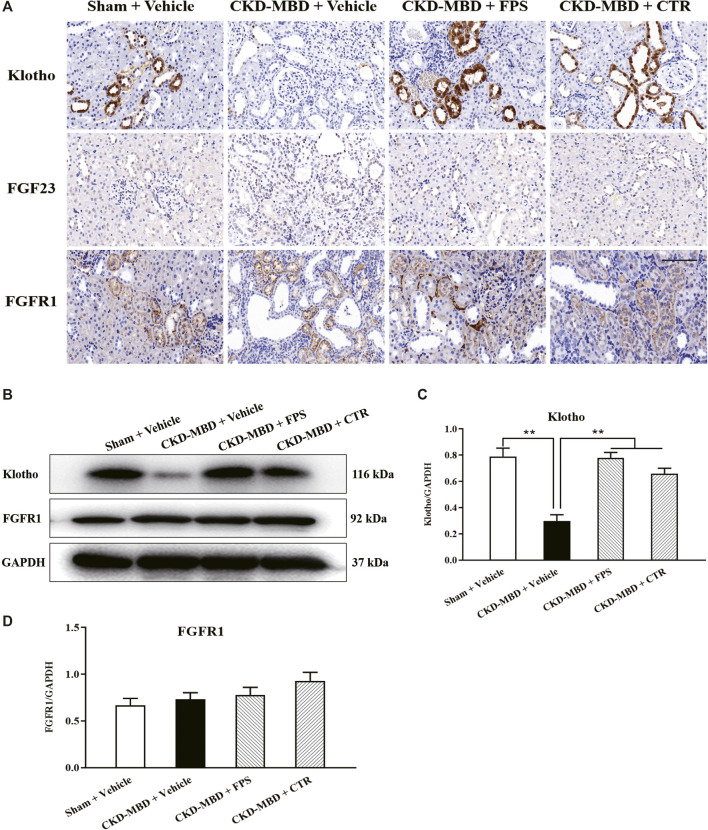
FPS and CTR regulated FGF23-Klotho signaling axis in vivo
(A) The protein expressional characteristics of Klotho, FGF23 and FGFR1 in renal tubulointerstitium of the kidneys in the four group rats. IHC staining × 200. Scale bar = 100 μm (B) The protein expressional levels of Klotho, FGF23 and FGFR1 in the kidney of the four group rats (C) The rate of Klotho/GAPDH (D) The rate of FGF23/GAPDH (E) The rate of FGFR1/GAPDH. The data are expressed as mean ± S.D. **p < 0.01.